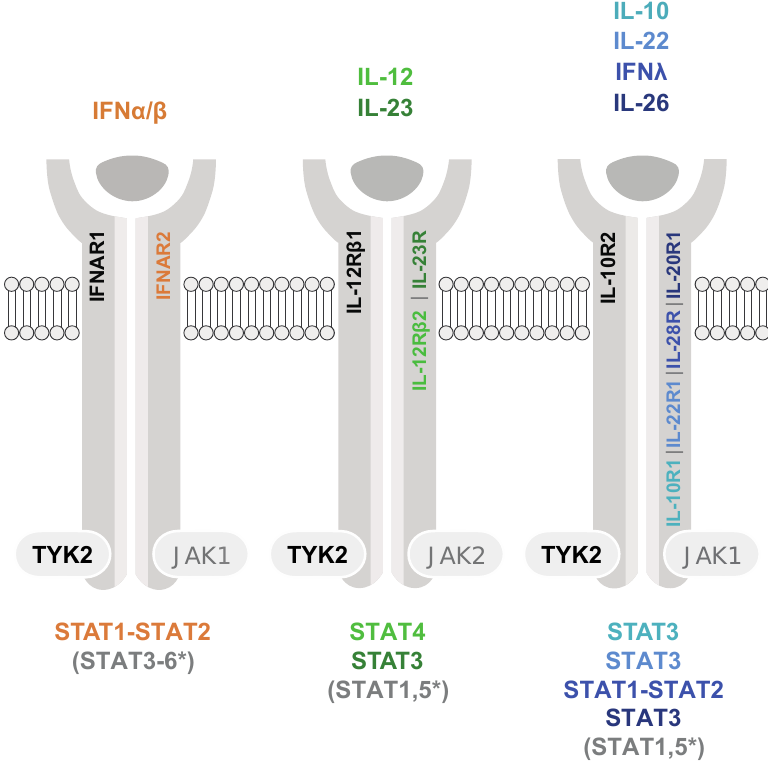
Figure 1. Cytokine receptor families signaling with the participation of TYK2 and JAK1 or JAK2. Cytokines are depicted only upon appearance in humans and mice and proof of TYK2 dependency. The color codes indicate the major STAT(s) activated by the respective cytokines. STAT1-STAT2 heterodimers combine with IFN regulatory factor (IRF) 9 and form the interferon-stimulated gene factor 3 (ISGF3) complex; *STAT activation is dependent on cell type or of less clear biological relevance.